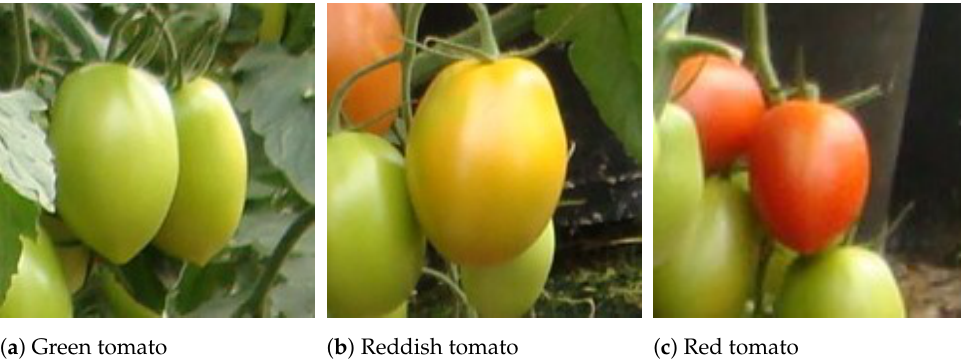
Figure 1. Tomatoes’ ripeness levels: ( a ) physiological or horticultural maturation; ( b ) early phase of ripening; and ( c ) ripened